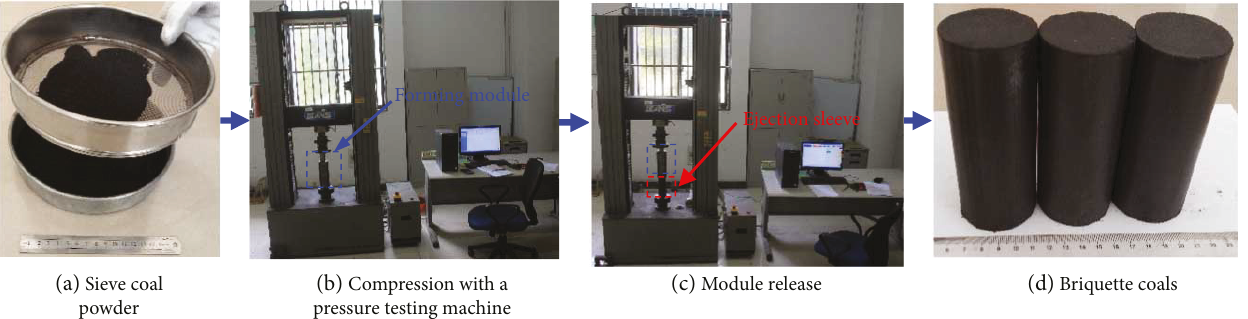
Figure 5: Preparation process of the briquette coal samples .